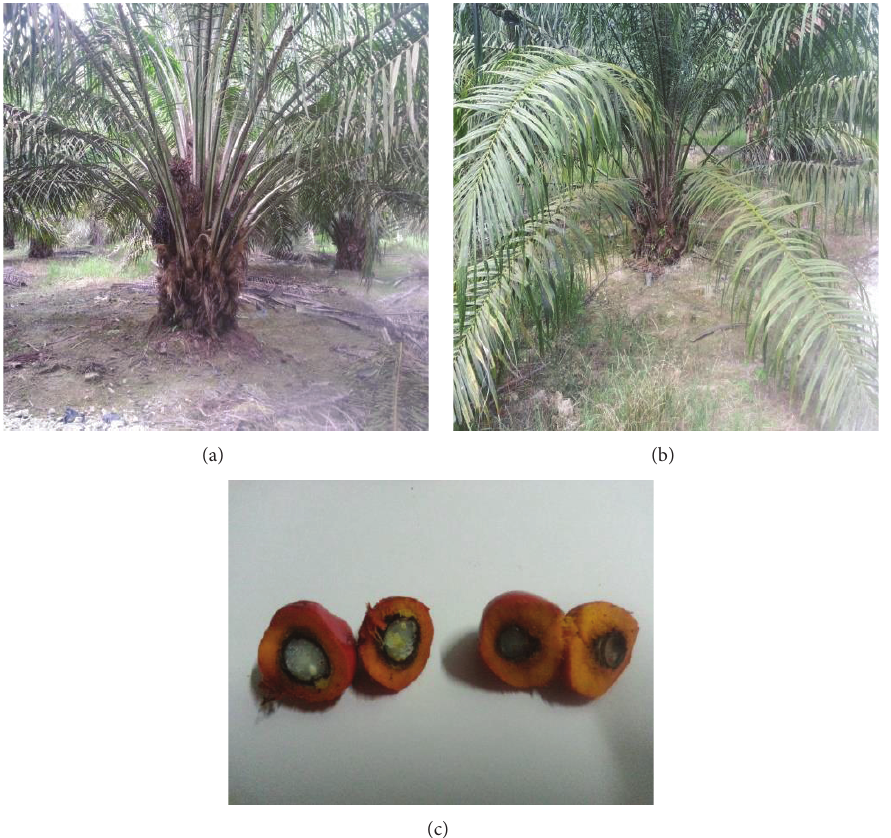
Figure 4: dura (a) and tenera (b) OPS aggregates taken from 3–5-year-old oil palm trees.